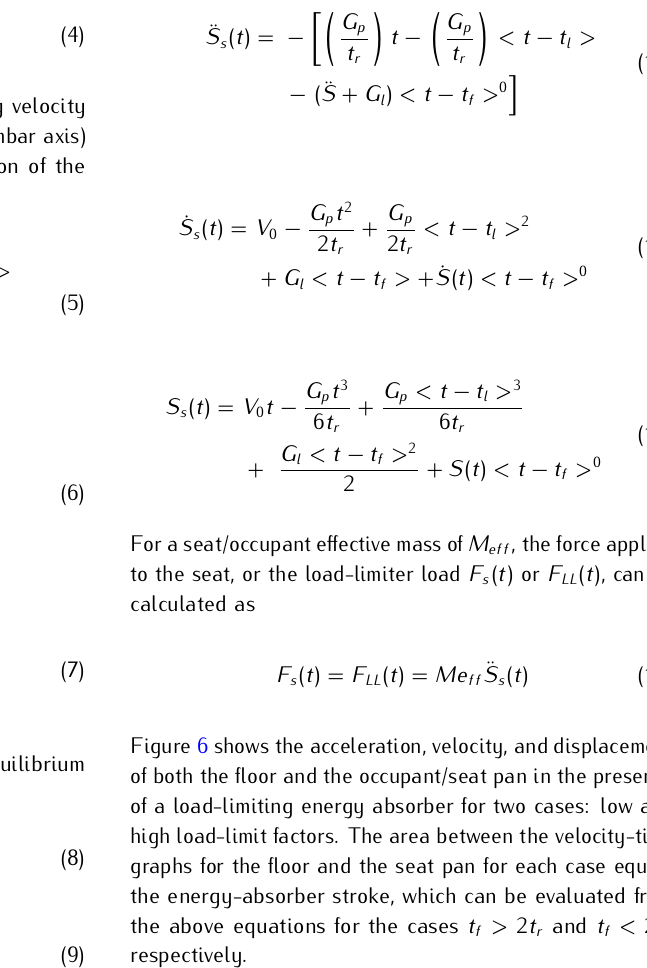
shown in Figure 5, where t r is the acceleration rise time, and G p is the peak